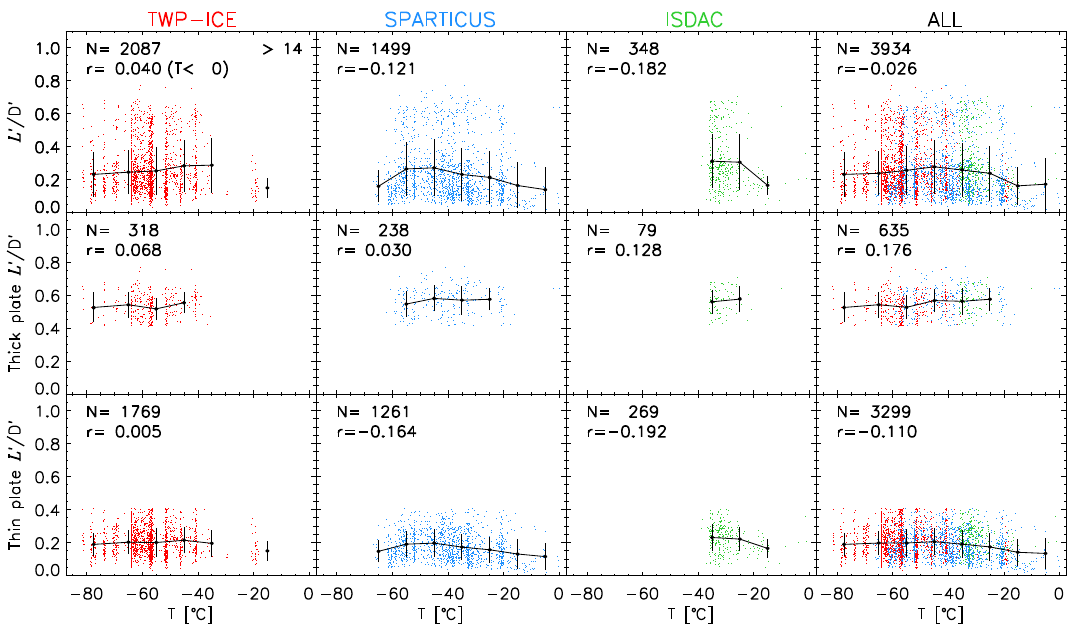
Figure 13. The projected aspect ratio ( L (cid:48) /D (cid:48) ) of all plates (top row), thick plates (middle row), and thin plates (bottom row) as a function of temperature. The correlation coefficient ( r ) for − 85 < T < 0 ◦ C is embedded in each panel.